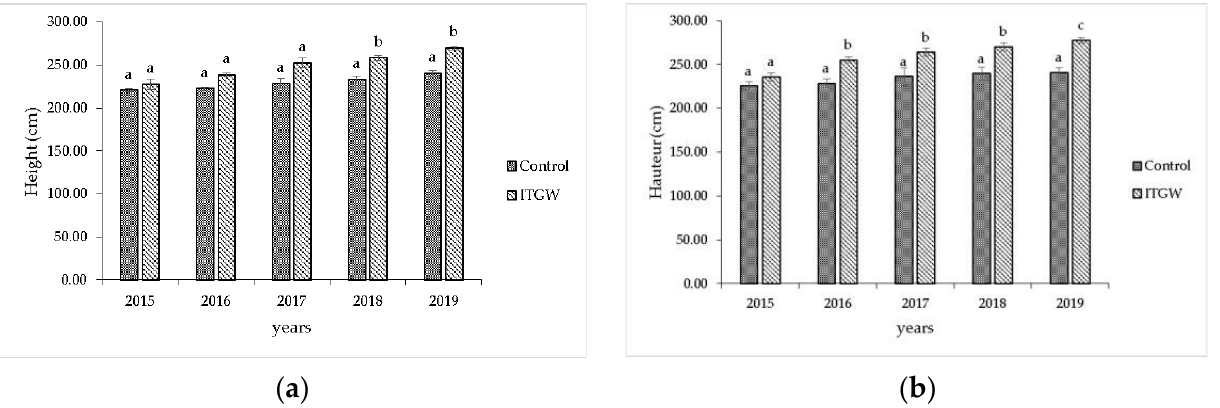
Figure 4. Variation in Height (H) of the two varieties of olive trees during the period 2015 – 2019: ( a ) Chétoui; ( b ) Picholine.